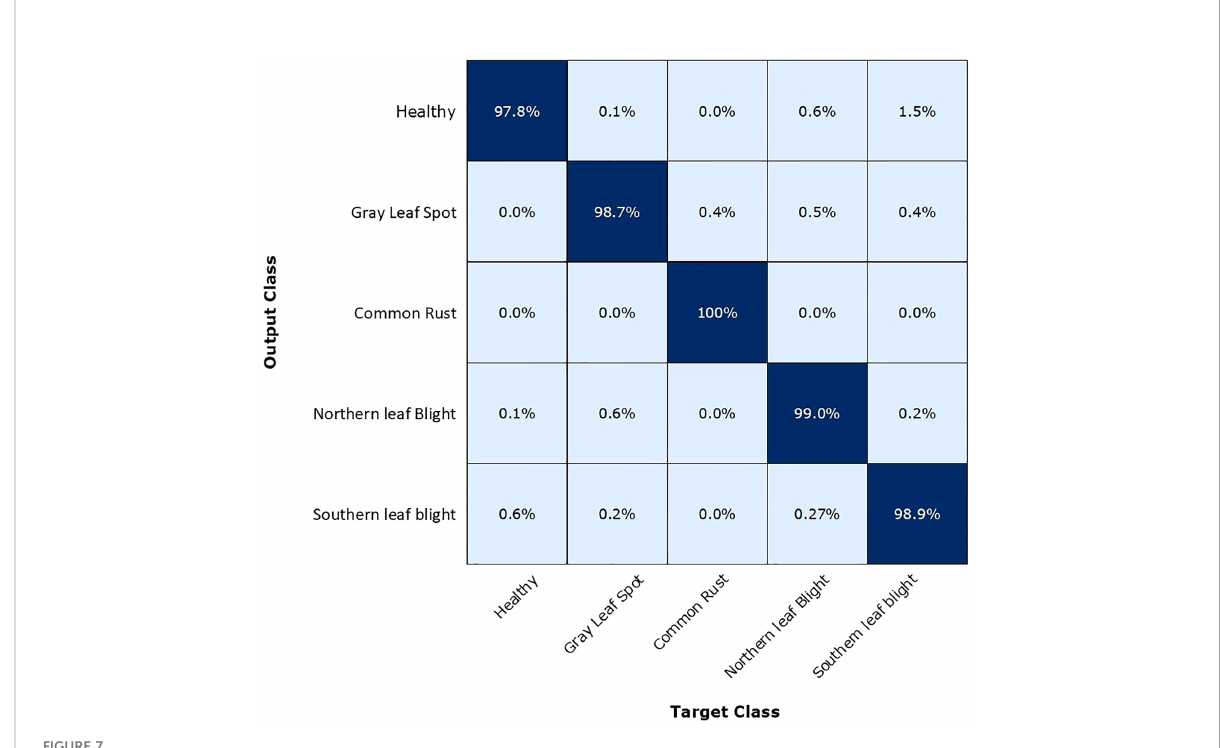
FIGURE 7 Confusion matrix of classi fi cation results for maize leaf disease using the test set.